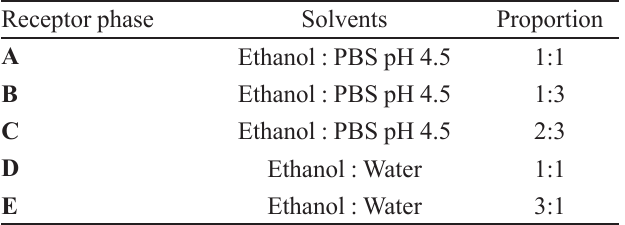
TABLE I - Receptor phases prepared for the solubility tests. Receptor phase